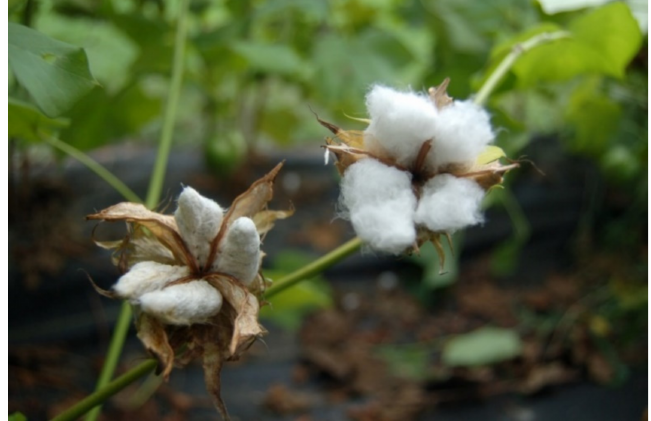
Figure 2. A Li 2 cotton mutant plant with mixed fiber phenotypes. Left boll, Li 2 - mix (i.e., short fiber in a Li 2 plant with mixed phenotypes); right boll, Li 2 - long